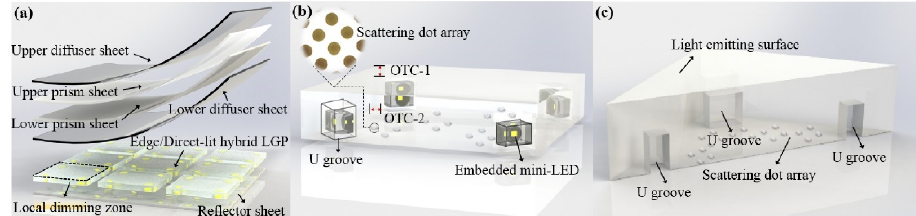
Figure 9. Schematic map: ( a ) Hybrid backlight equipped with sub-LGPs as physical local dimming zones; ( b ) Single local dimming zone enabled by edge-lit mini-LEDs embedded in the U grooves of the sub-LGP; ( c ) Cross-sectional view along the diagonal of the sub-LGP